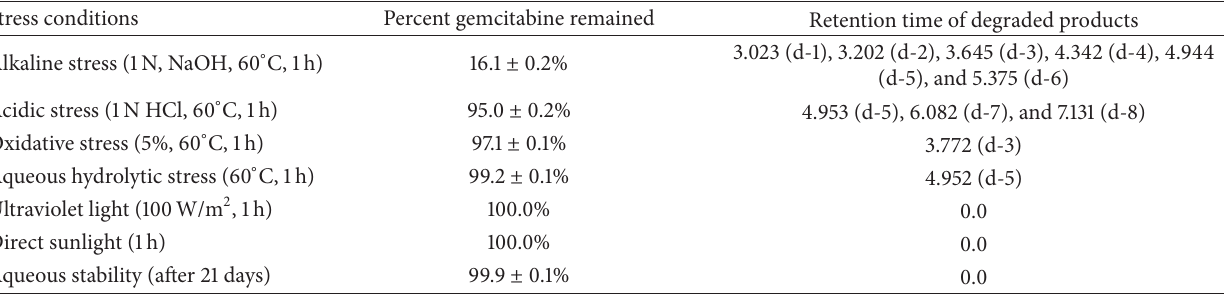
Table 6: Stability data under different stressed conditions.